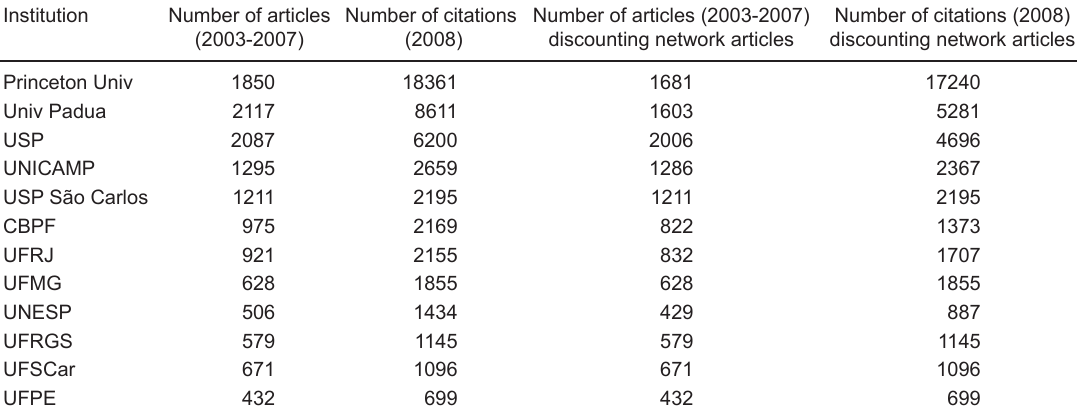
Table 3. Effect of network articles on the total number of citations.